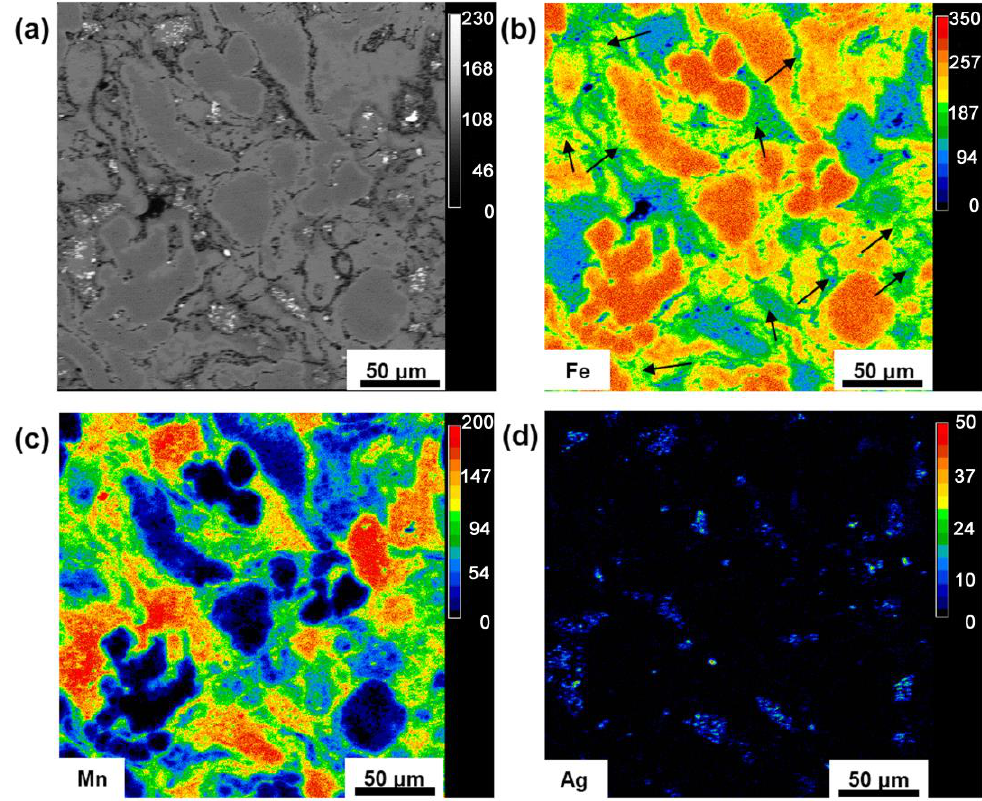
Figure 1. The microstructure of the consolidated sample ( a ) backscattered electron microscopy (BSE) and microprobe analysis (EPMA); ( b ) Fe (arrows represent the γ -FeMn phase); ( c ) Mn; and ( d ) Ag. Table 2. Phase analysis and mechanical properties of the MP sample.